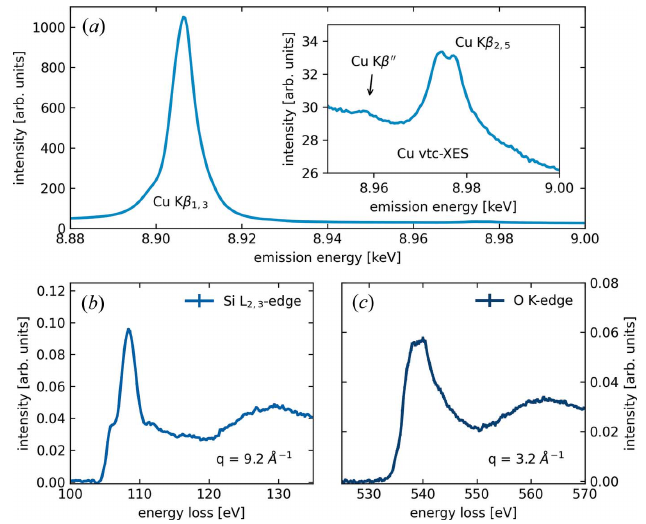
Figure 4 ( a ) A non-resonant X-ray emission spectrum of the Cu K (cid:6) emission line, as well as the valence-to-core part of the same emission line of a copper- exchange zeolite. ( b ) An Si L 2,3 -edge excitation spectrum measured at high momentum transfer q and ( c ) an O K -edge spectrum at low momentum transfer of the same sample. The XES spectra were measured simultaneously to the two XRS